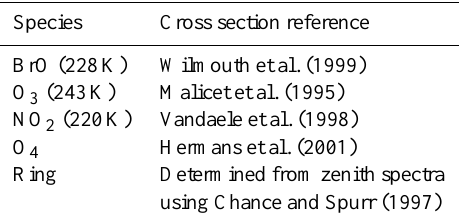
Table 2. Cross sections used in spectral analysis. Each cross section is convolved using an instrument function determined by the 334nm Hg peak. Species